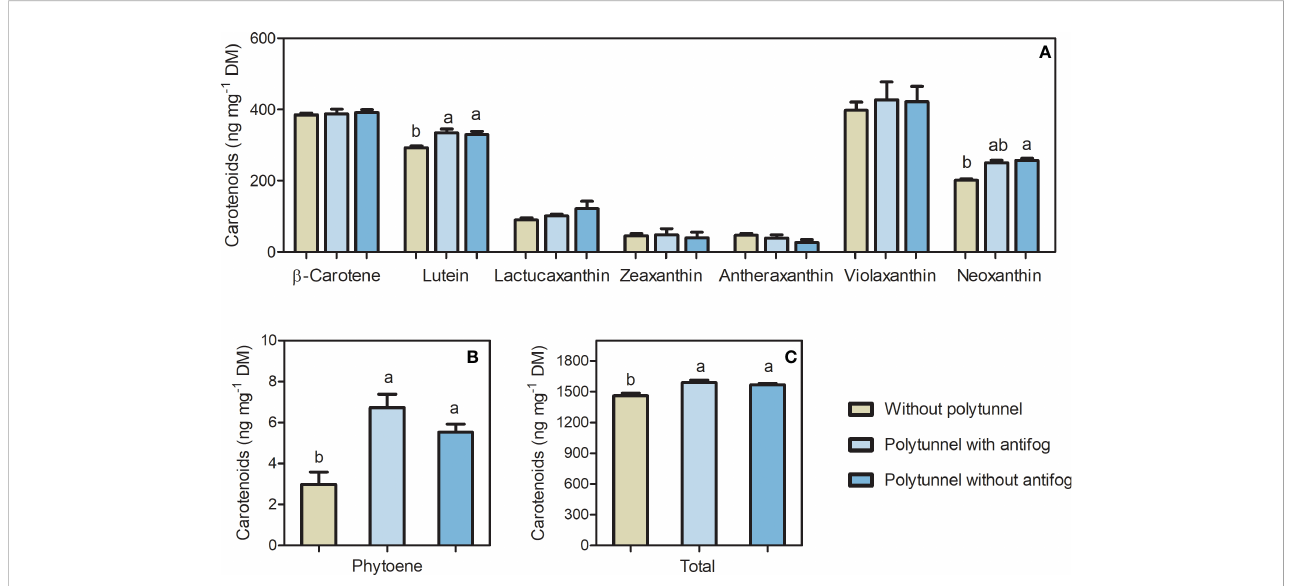
FIGURE 4 Total carotenoid content affected by polytunnel cultivation. Carotenoid content (ng mg -1 DM) in lettuce grown without or under polytunnels with and without antifogging additives. (A) Individual carotenoids b -/ ϵ -branch and downstream, (B) upper pathway metabolite phytoene, and (C) total carotenoids. First experimental repetition in April is shown. The data are expressed as mean ± SE (n = 4). Signi fi cant differences (p ≤ 0.05) between treatment of individual compounds and total content are indicated by different letters; no letters indicate absence of signi fi